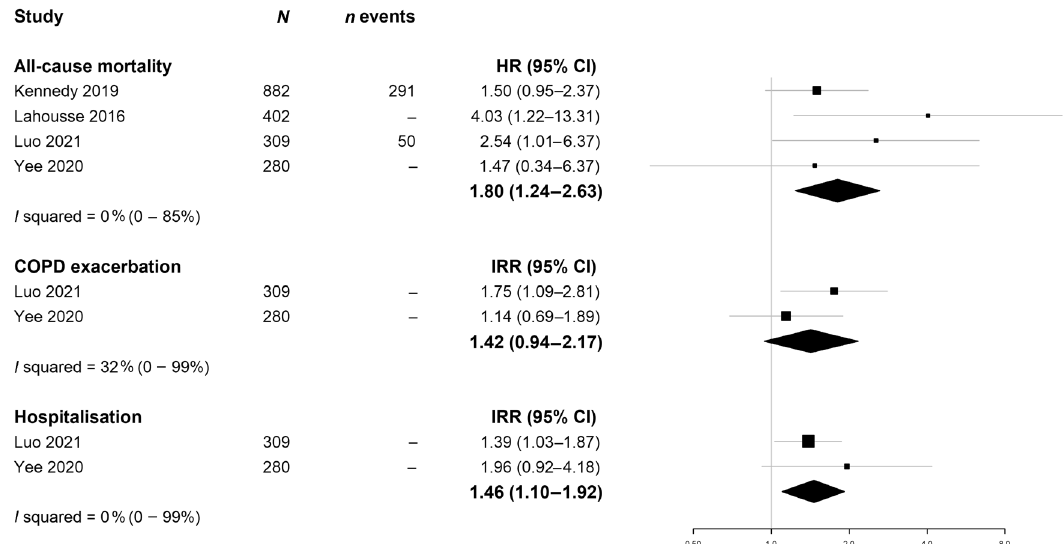
Fig. 6 Meta-analyses of random-effects meta-analysis of the relationship between frailty phenotype (frailty phenotype de fi nition) and mortality, COPD exacerbation and hospitalisation. Points indicate hazard ratios (HR) or incidence rate ratios (IRR), respectively. Whiskers show 95% con fi dence intervals